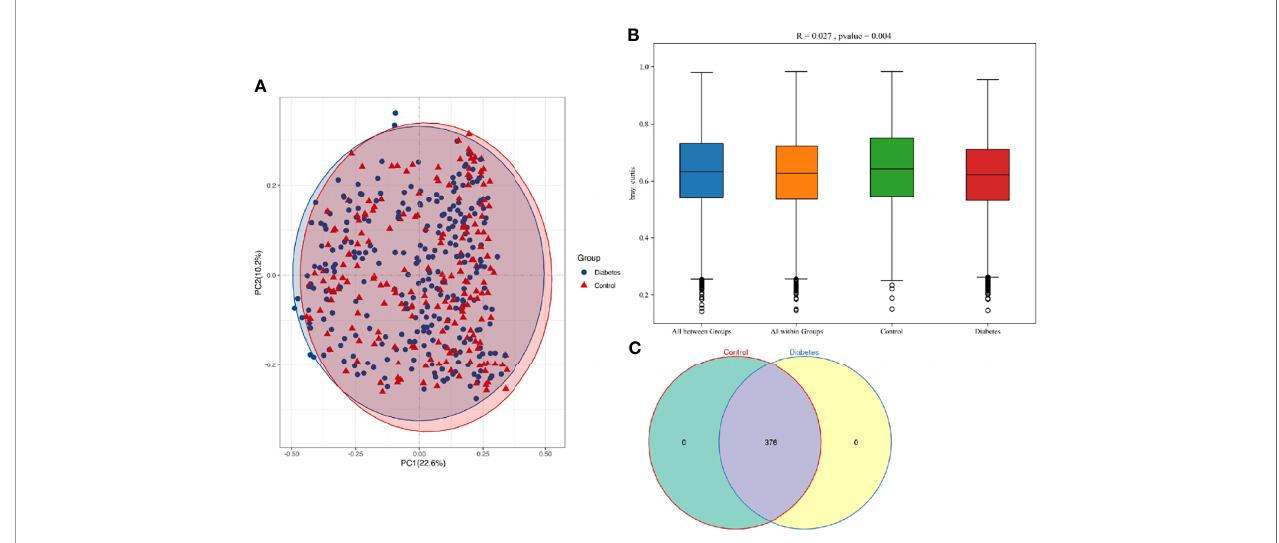
FIGURE 2 | (A) PCoA based on Bray-Curtis distances for all samples from T2DM patients and healthy controls (T2DM, n = 273; control, n = 197). Ellipses represented 95% con fi dence level. The blue and red ellipses almost overlapped, indicating insigni fi cant differences between T2DM patients and healthy populations. (B) R and p values for the beta diversity based on Bray-Curtis distance calculated using Anosim analysis (analysis of Similarities). The closer the R value was to 1, the greater the differences between groups than the differences within groups. The smaller the R value was, the less signi fi cant the differences between them. p < 0.05 showed the high reliability of the test. (C) The numbers in each independent or overlapping region of the Venn diagram representing the number of features in each corresponding set, indicating that the “ core microbiome ” of T2DM patients and healthy controls overlapped